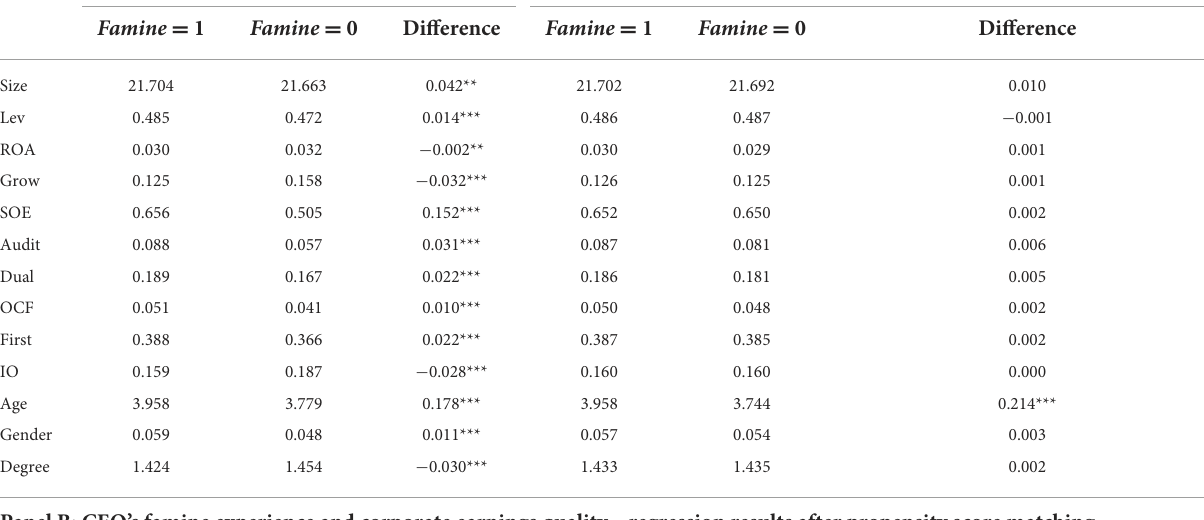
TABLE 8 Panel A: Propensity score matching parallelism hypothesis test. Before PSM